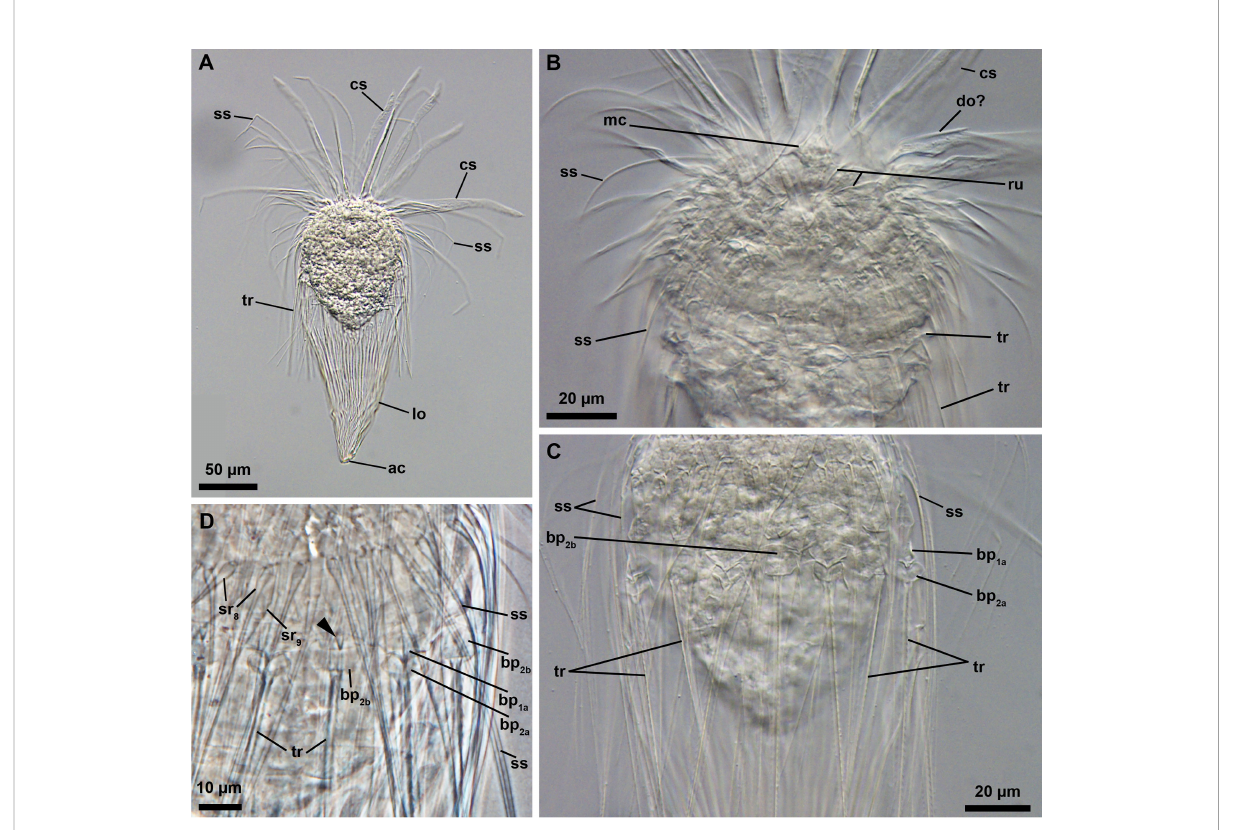
FIGURE 1 Light micrographs of the adult female of an undescribed species, Rugiloricus sp. 1 (NHMD-621046). (A) Overview of the specimen. Lateral view, anterior faces up. Note that the mouth cone is retracted inside the introvert. (B, C) Anterior region of the body. (D) Close-up of several basal plates of the neck region. Arrowhead points to the medial, posteriorly oriented spike of a basal plate of the anteriormost row. bp 1a/b , anterior row basal plates of type a and b; bp 2a/b , posterior row basal plates of type a and b; cs, clavoscalids; lo, lorica; mc, mouth cone; sr 8,9 , spinoscalids of 8 th or 9 th row; ss spinoscalids; ru, ruff; tr,